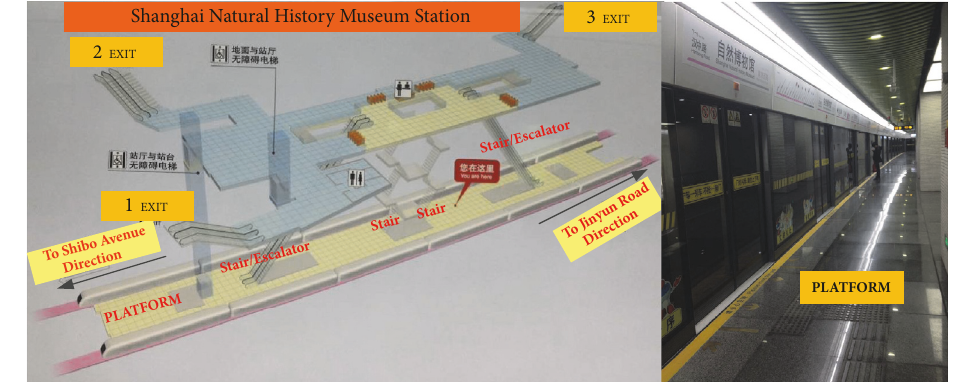
Figure 19: The simplified 3D diagram of Shanghai natural history museum station.